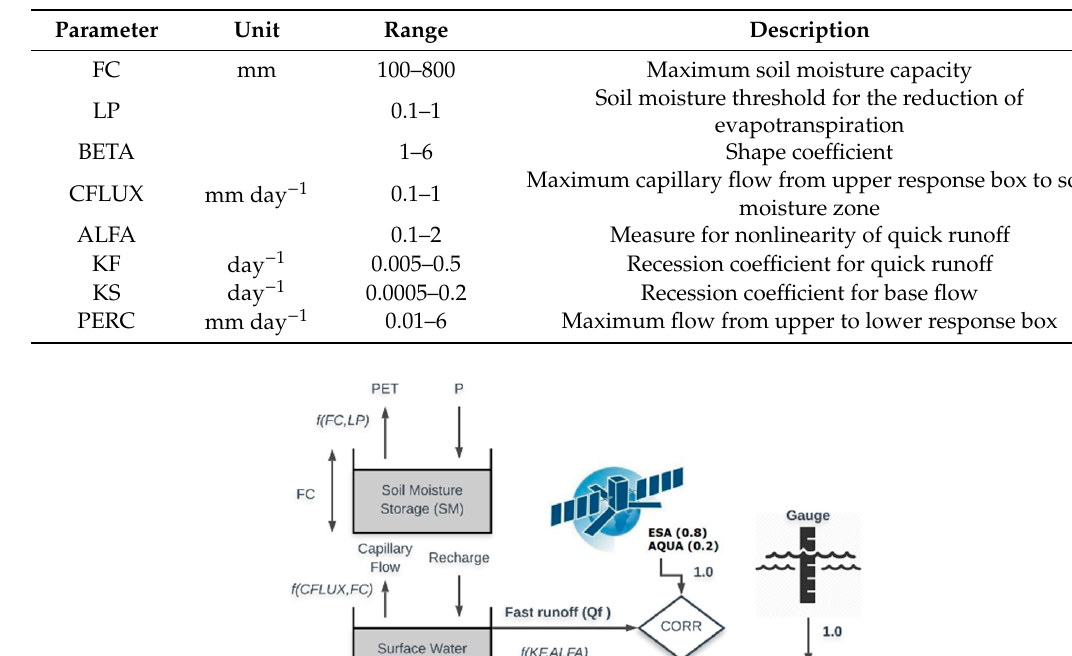
Table 2. Description of the Hydrologiska Bryåns Vattenbalansavdelning (HBV) model parameters.